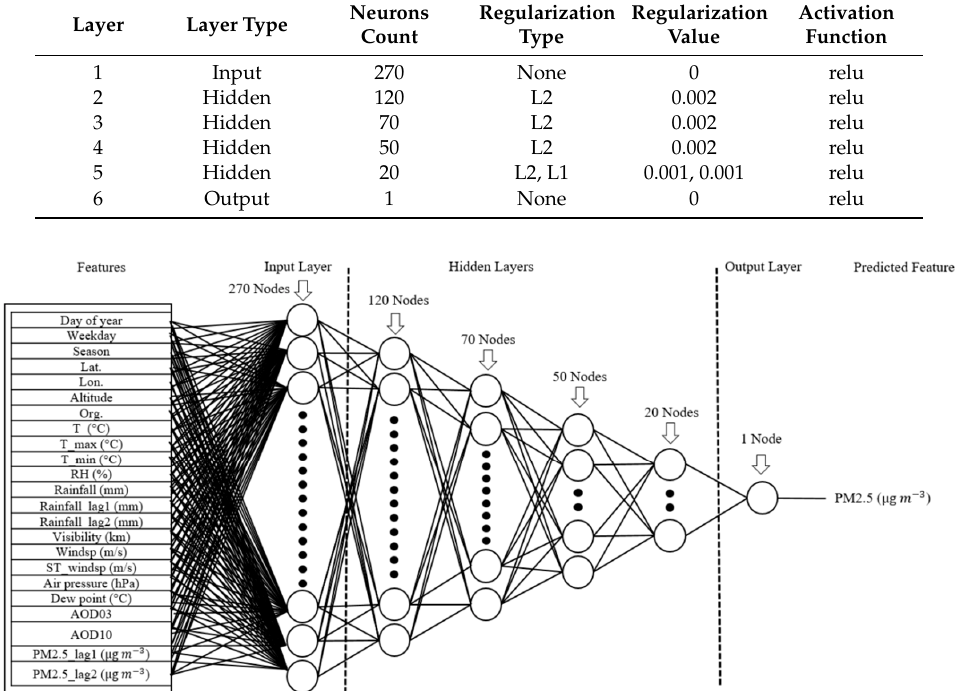
Table 4. The deep learning layer configuration. A six-layer neural network with a “relu” activation function that is equipped with regularization to avoid overfitting, was used.